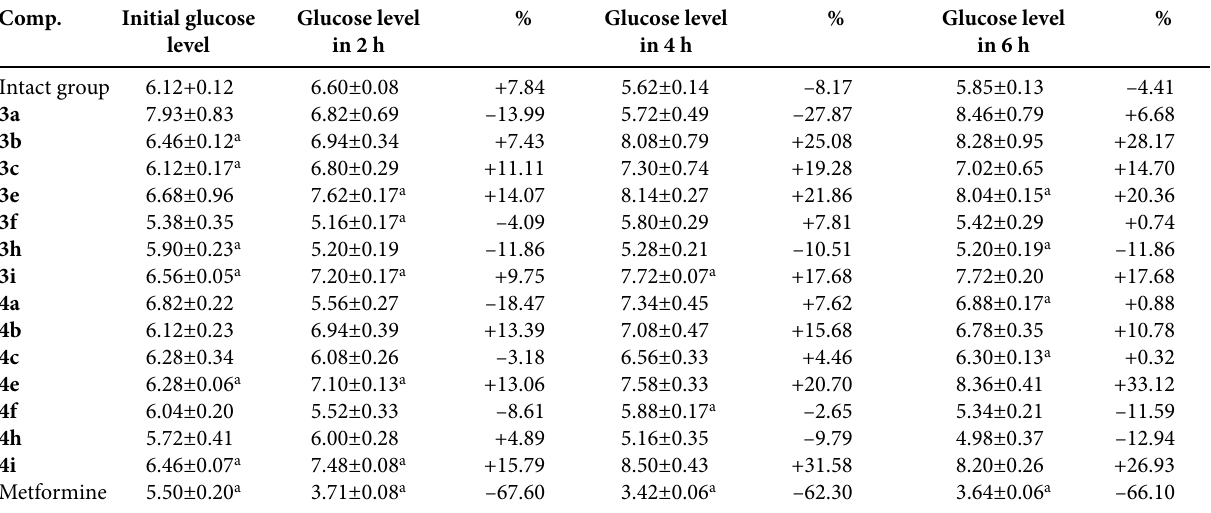
Table 1 The synthesized compounds’ influence on glucose level in blood of experimental animals (%)